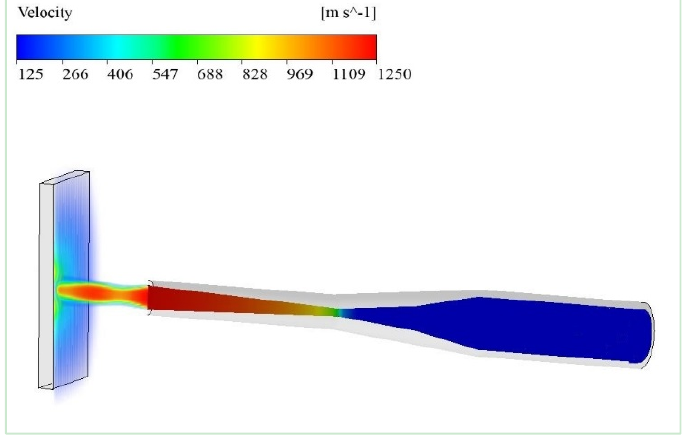
Figure 9. Simulation of gas velocity for cold spray supersonic jet at 800 °C and 3 MPa estimated holistically from nozzle stagnation zone to the substrate surface, predicted by 3D multicomponent model.